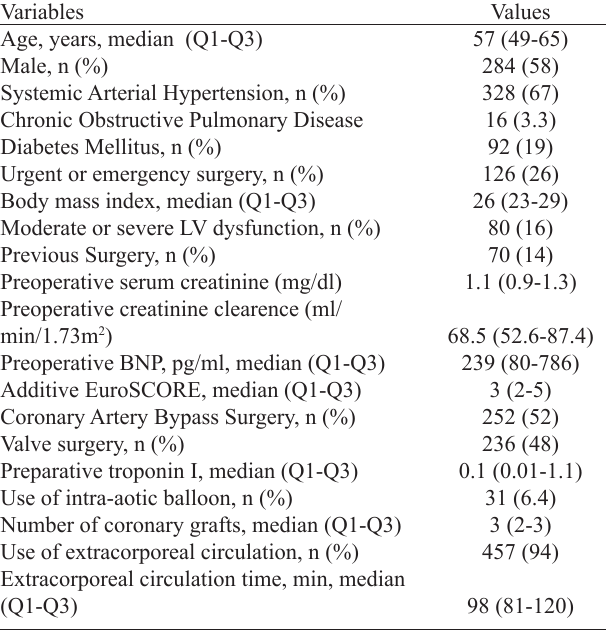
Table 1. Baseline characteristics of patients included in the study (n = 488).